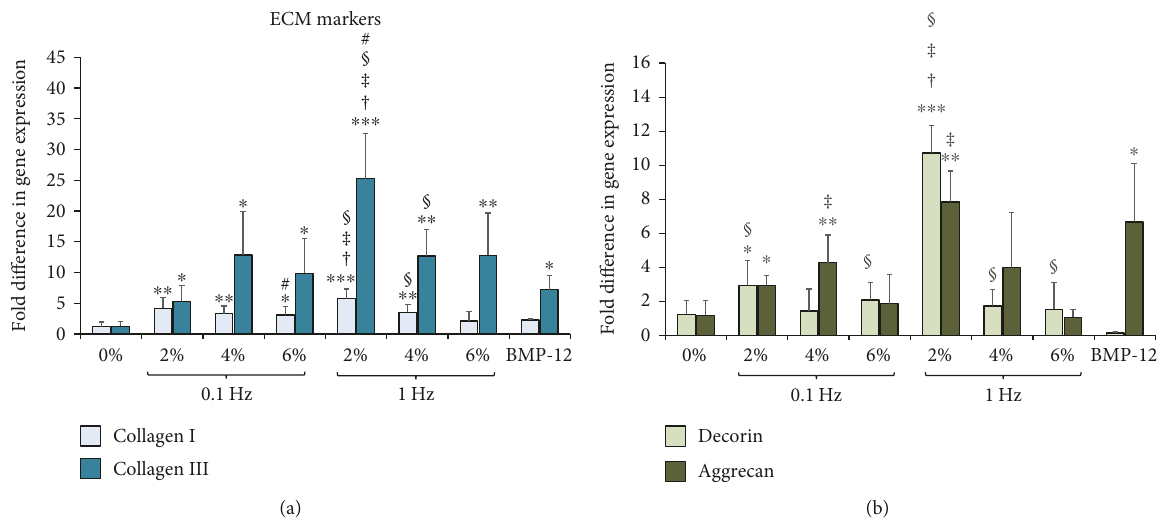
Figure 5: E ff ect of uniaxial tensile loading on ECM gene expression of ASCs encapsulated within 3D collagen sca ff olds. (a) Gene expression pro fi les of ASCs encapsulated within collagen sca ff olds subjected to BMP-12 treatment or uniaxial loading at 0%, 2%, 4%, and 6% strains at 0.1Hz and 1Hz. The graphs depict fold changes in various extracellular matrix genes: collagen I and collagen III, (b) GAGs: decorin and aggrecan. ∗ indicates signi fi cant fold increase with respect to the 0% samples. ∗ indicates p < 0 05 , ∗∗ denotes p < 0 01 , and ∗∗∗ corresponds to p < 0 001 . † represents a signi fi cant di ff erence between 2% and 4% groups while ‡ is the statistical di ff erence with respect to 6% group, both with a 95% con fi dence interval. # represents a signi fi cant di ff erence between 0.1Hz and 1Hz groups at the same magnitude of strain with p < 0 05 . § depicts signi fi cant di ff erence with respect to unloaded samples chemically stimulated with BMP-12 with p < 0 05 . The mechanically stimulated samples display an increased level of ECM markers compared to the nonloaded sca ff